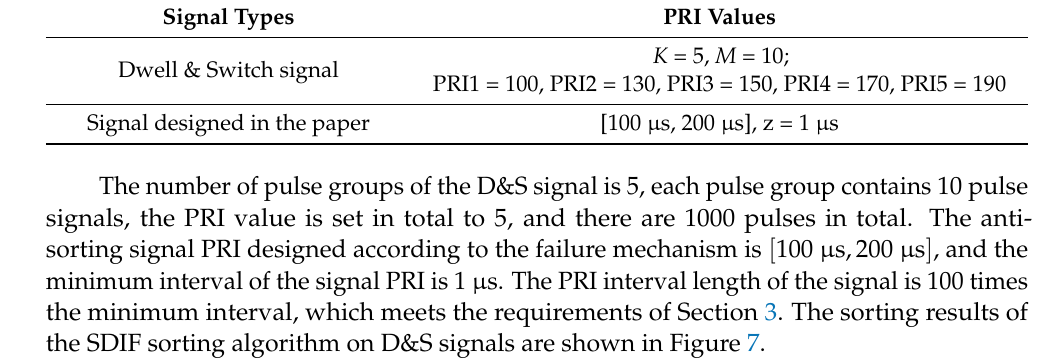
Table 3. The PRI values of the D&S signal and the signal designed in this paper. Signal Types